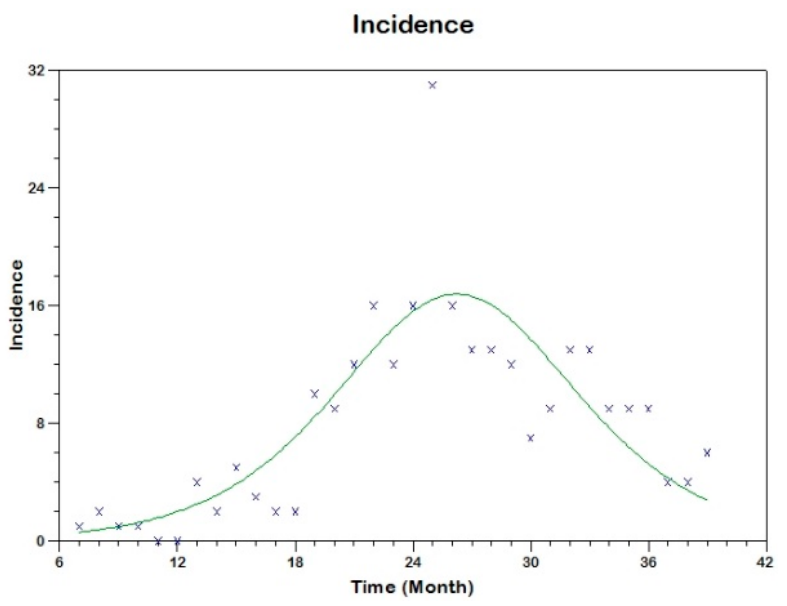
Figure 9 . Model fit to the reported incidence of Madrid-Spain outbreak using Method 2. Figure 9. Model fit to the reported incidence of Madrid-Spain outbreak using Method 2.